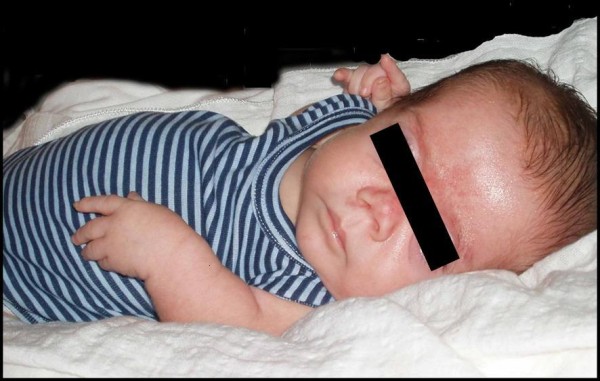
Patient 2, 2 years. Note flat mid-face, depressed nasal bridge.